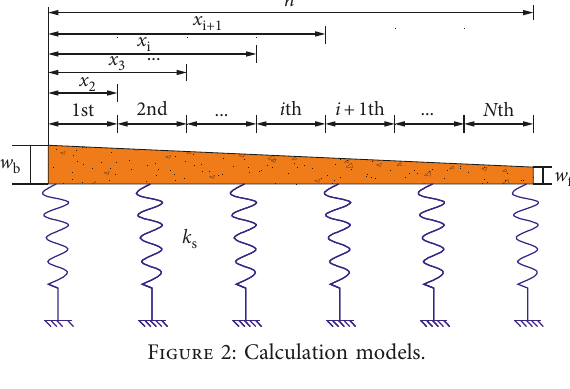
Figure 2: Calculation